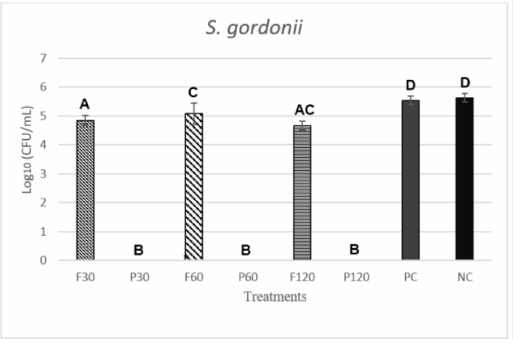
Figure 3. Mean values and standard deviations log 10 CFU/mL of single-species biofilms composed of S. gordonii treated with LTP, 0.12% chlorhexidine (positive control), or 0.89% NaCl solution (negative control). Different letters indicate significant statistical difference (n = 9; p ≤ 0.05; ANOVA, Tukey’s Test). F30, F60, and F120 (argon gas—flow control treatment for 30 s, 60 s, and 120 s); P30, P60, and P120 (LTP treatment for 30 s, 60 s, and 120 s); PC (positive control); and NC (negative control).